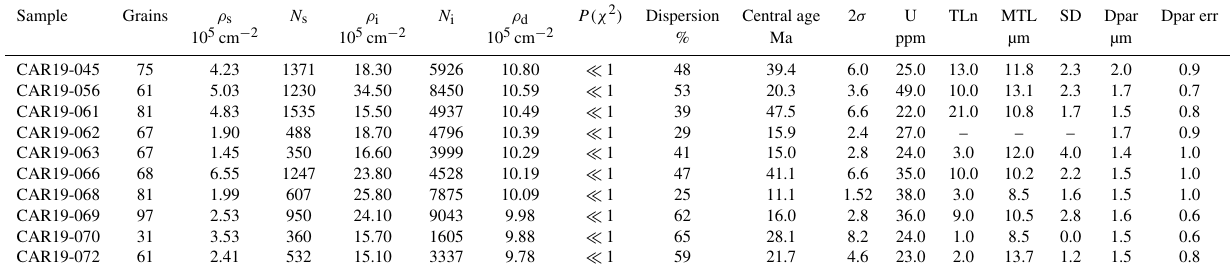
Table 2. Apatite fission-track data. ρ s : spontaneous track density; N s : number of spontaneous tracks counted in the sample; ρ i : induced track density; N i : number of induced tracks counted on the mica detector; ρ d : dosimeter track density; P(χ 2 ) : chi-square probability that the sample contains a single age population, U: uranium content; TLn: number of track lengths measured; MTL: mean track length; SD: standard deviation of track length measurement; Dpar: mean Dpar value for the sample; Dp err: mean error in the Dpar